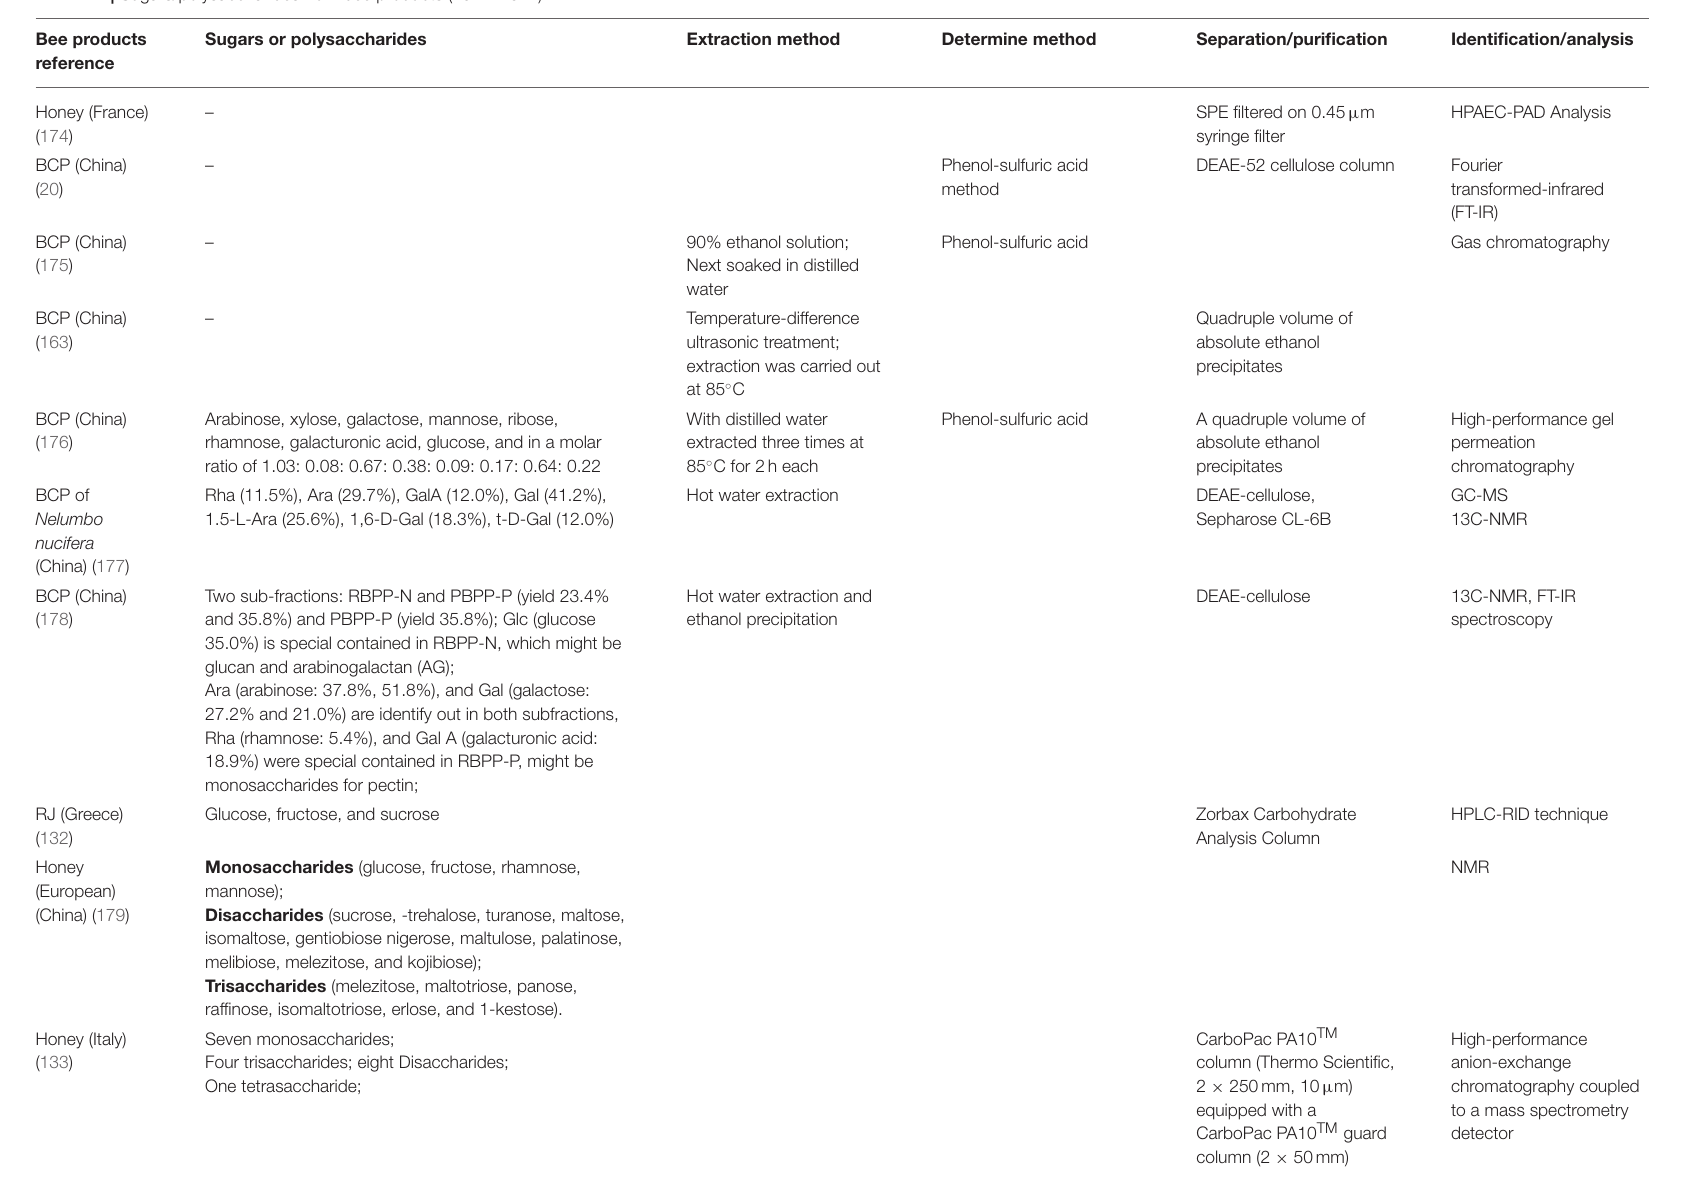
TABLE 2 | Sugars/polysaccharides from bee products